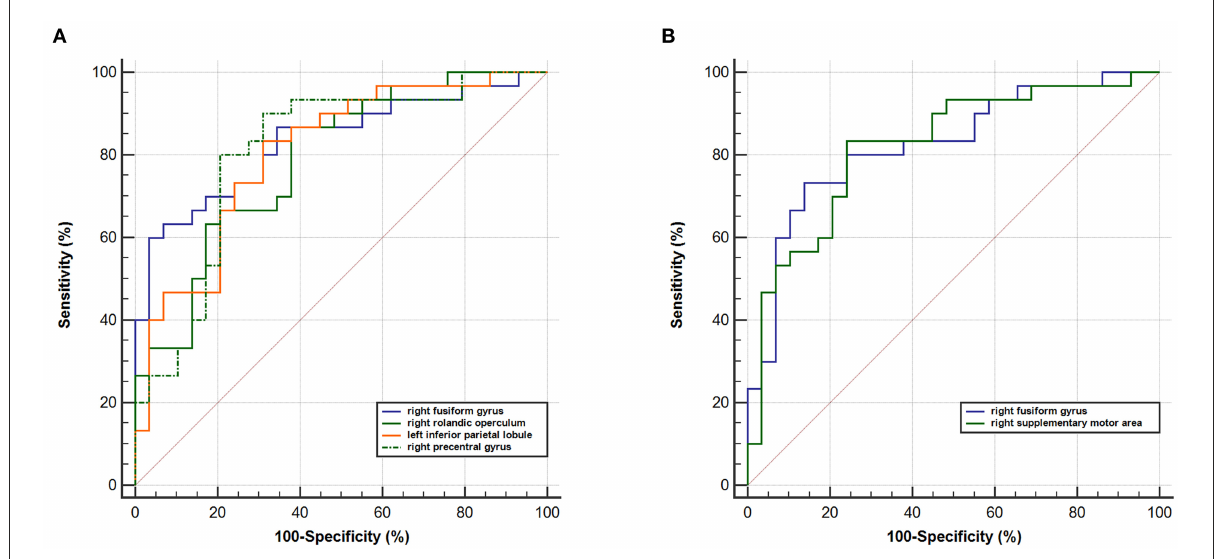
FIGURE4 ROC curve analysis. ROC curve for altered RSFC patterns based on the left (A) rHipp and (B) cHipp to distinguish children with PNE from HCs. rHipp, rostral hippocampus; cHipp, caudal hippocampus; PNE, primary nocturnal enuresis; HCs, healthy